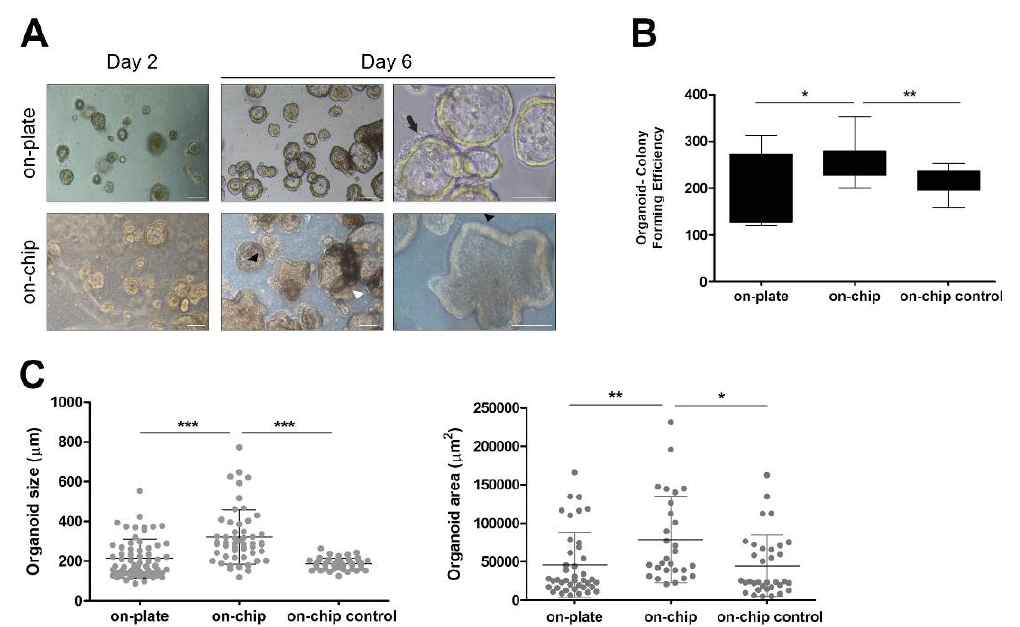
Figure 4. Organoid-forming efficiency within OrganoidChip. ( A ) Representative images of organoids morphology at days 2 and 6 of culture. On day 6, Iso-50 organoids cultured on-plate exhibited a cystic-like morphology with a visible lumen. In contrast, the organoids cultured on-chip are multi-layered with crypt-like projections or display a thick epithelial cell layer containing glandular structures. Scale bar: 100 µ m. ( B ) Quantification of organoid colony-forming efficiency at day 6 of culture. The results are reported as the mean ± SD of three independent experiments. ( C ) Analysis of organoid size and area at day 6 of culture. The results are described as mean ± SD of a total of 50 organoids in three independent experiments subjected to the analysis (Student’s t -test: * p ≤ 0.05; ** p ≤ 0.01; *** p ≤ 0.001).